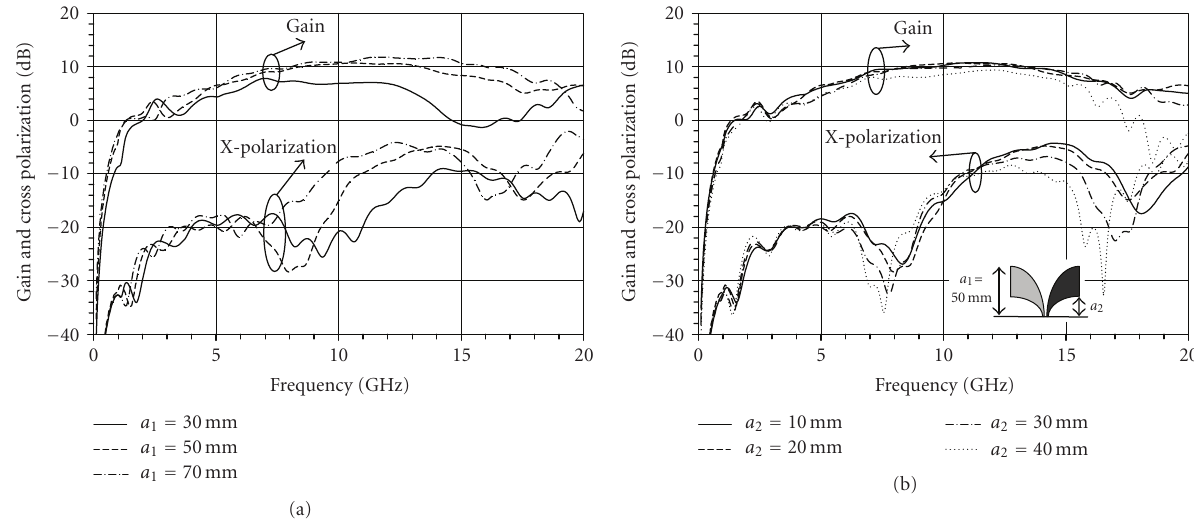
Figure 7: Gain and cross-polarization levels for varying the length of slot taper, a 1 , and outer taper, a 2 , of the slotline radiator.